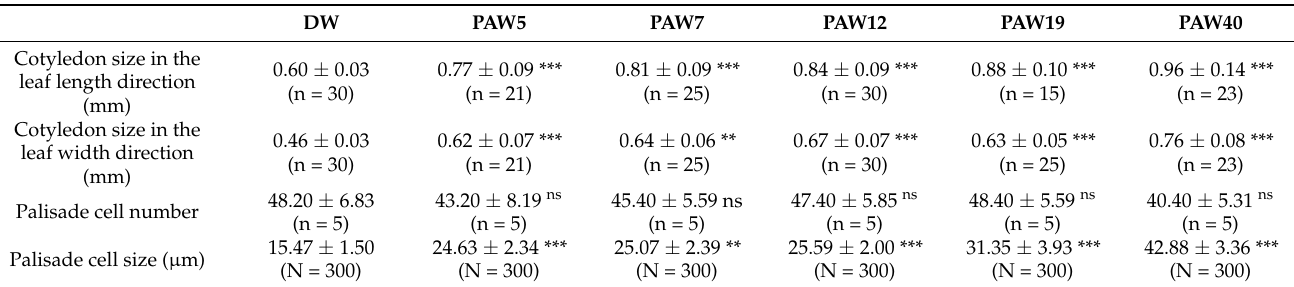
Table 3. Cotyledon size and palisade cell size and number of Arabidopsis grown in the DW and PAW treatment condition at 10 days after